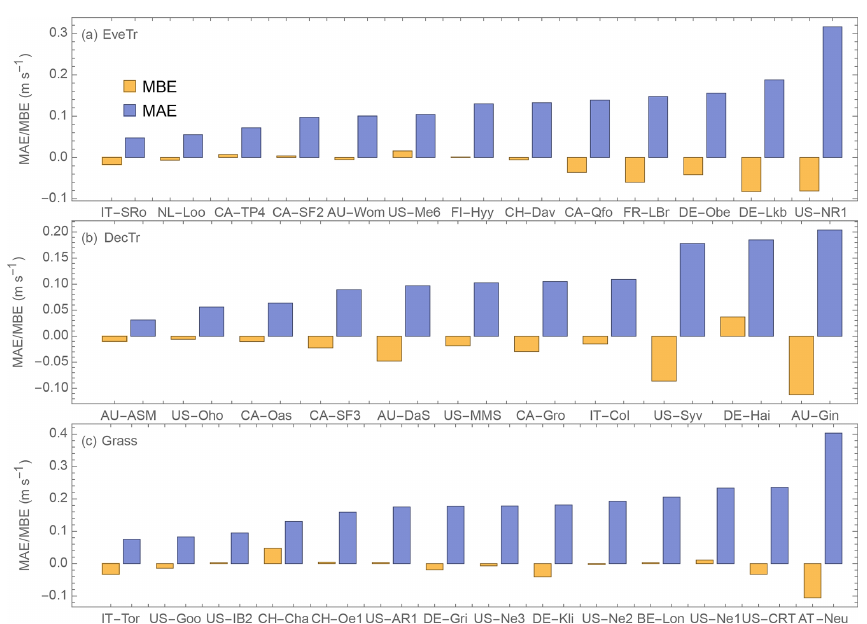
Figure B2. MAE (blue) and MBE (orange) for modelled wind speed under neutral conditions for three SUEWS PFTs: (a) EveTr, (b) DecTr and (c)